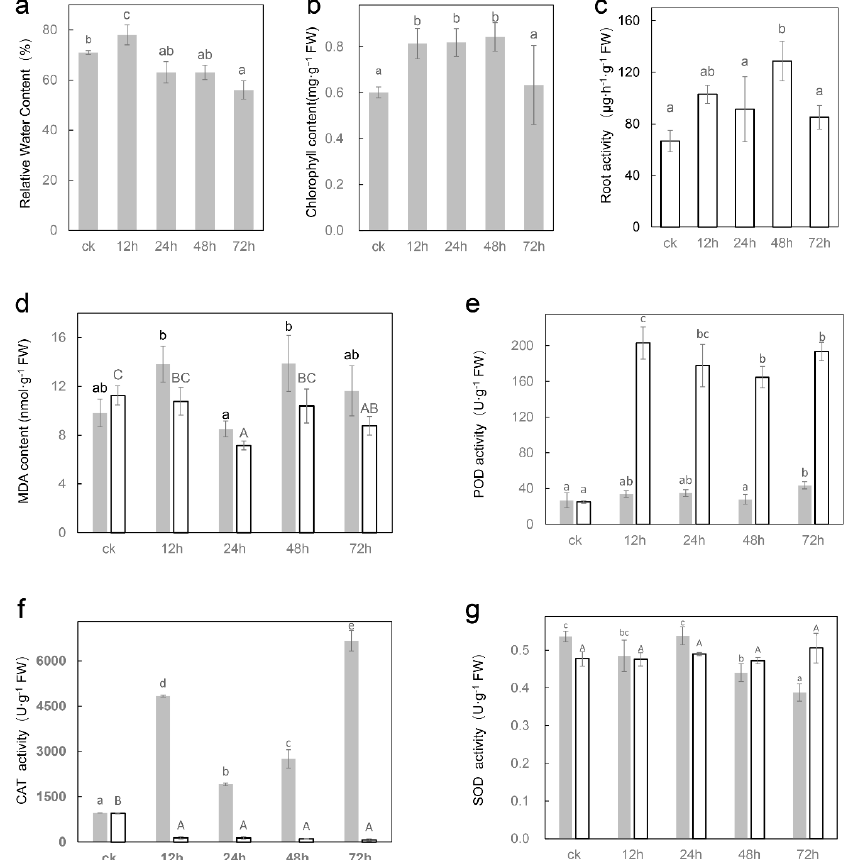
Figure 1. The physiological indexes of sugar beet O68 seedlings under different durations of salt treatments. ( a ) relative water content ( b ) chlorophyll content ( c ) root activity ( d ) MDA content ( e ) POD activity ( f ) CAT activity ( g ) SOD activity. The gray bars represent leaves and the white bars represent roots. The significance of leaves is marked with lowercase letters and that of roots is marked with uppercase letters. Triplicate biological replicates were performed. Different letters indicate significant differences according to Student − Newman − Keuls ( p < 0.05).